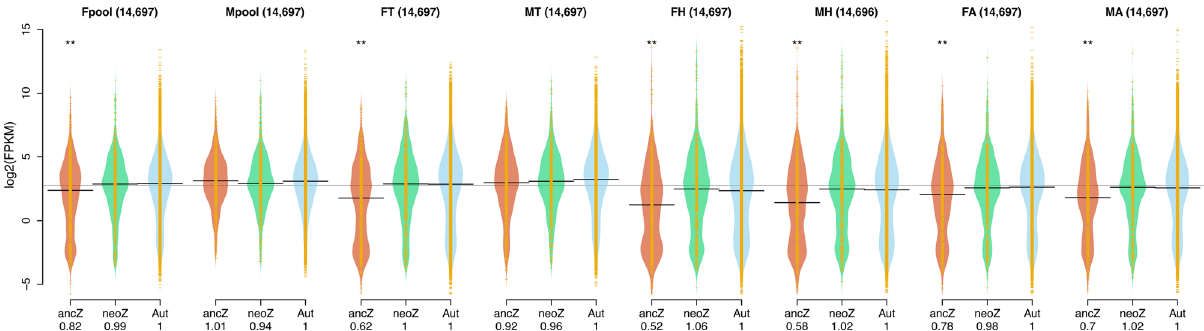
Fig. 4 Whole-chromosome expression in females ( ZW ) and males ( ZZ ) in four sample types of D. plexippus . Sampled assayed: pools of whole-body males and females (Mpool, Fpool); individual samples of thorax (MT, FT), abdomen (MA, FA), and heads (MH, FH). The bean plots show the distribution of absolute normalized log 2 expression values in FPKM for the ancestral (anc-) and neo (neo-) portions of chromosome 1 (i.e. the Z chromosome) and the autosomes. The horizontal line in each plot corresponds to the median expression value. A global median value across sample types is shown with a gray line in the background. The median Z : A ratios are shown at the bottom. For each sample type, statistical signi fi cance was established according to Wilcoxon signed-rank tests and upon applying a Bonferroni correction (**, P < 0.01). The number of genes considered is indicated on top of each bean plot. A minimum expression threshold of 0.01 FPKM was required. The results with other thresholds and for the autosomes considered separately can be found in Supplementary Figs. 21, 22 respectively. Raw data for this and related fi gures can be found in Supplementary Data